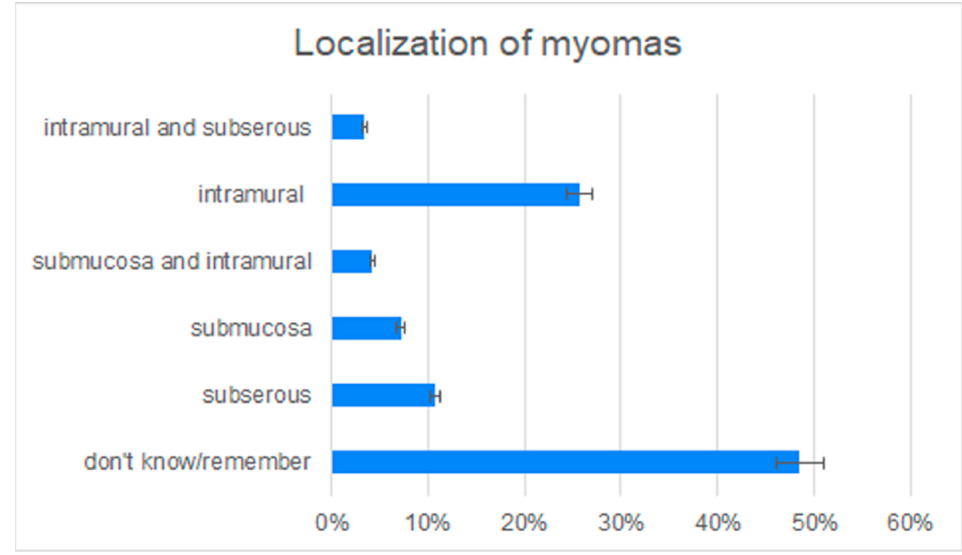
Figure 2. Localization of the myoma reported by the patients.